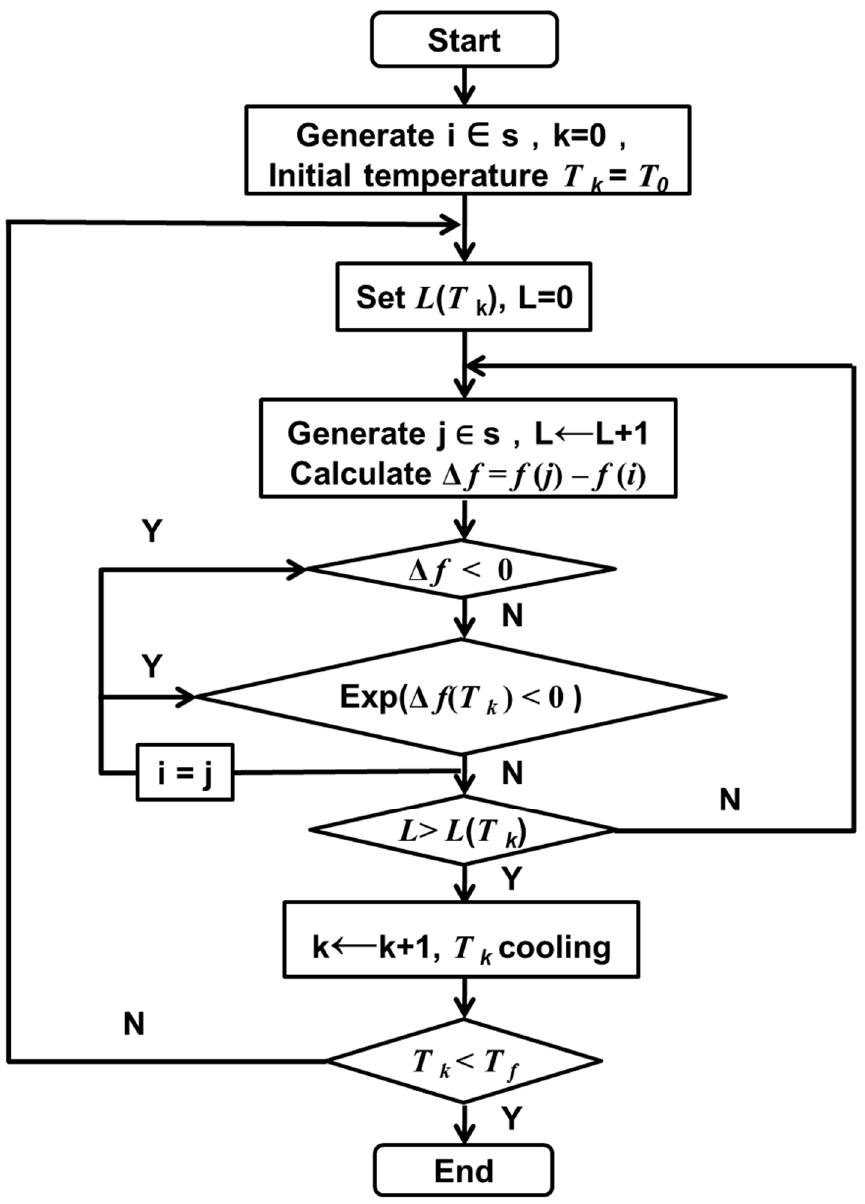
Figure 3. Description of simulated annealing.